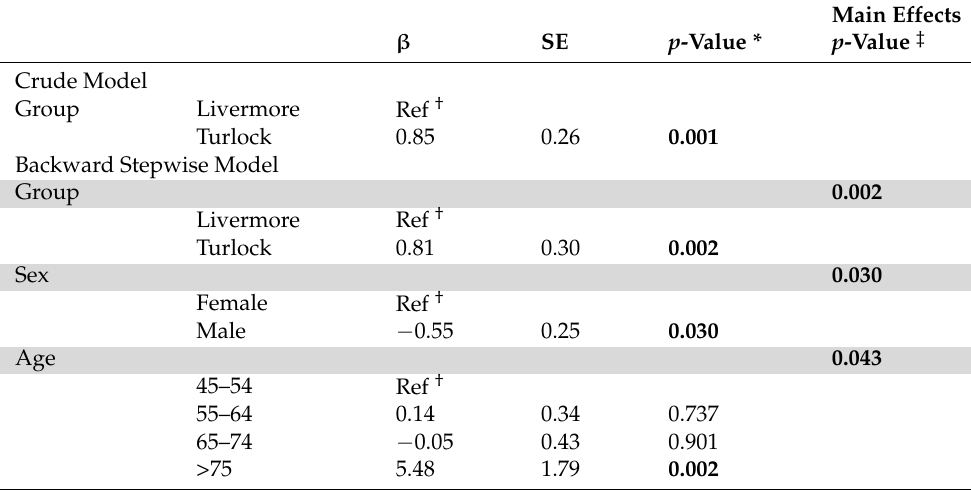
Table 2. Multivariable linear regression analysis assessing Mediterranean diet adherence between groups adjusted for demographic categories, stages of change, barriers, and benefits. Linear regres- sion analysis using a crude and multivariable backward stepwise model to assess Mediterranean diet adherence in the Turlock